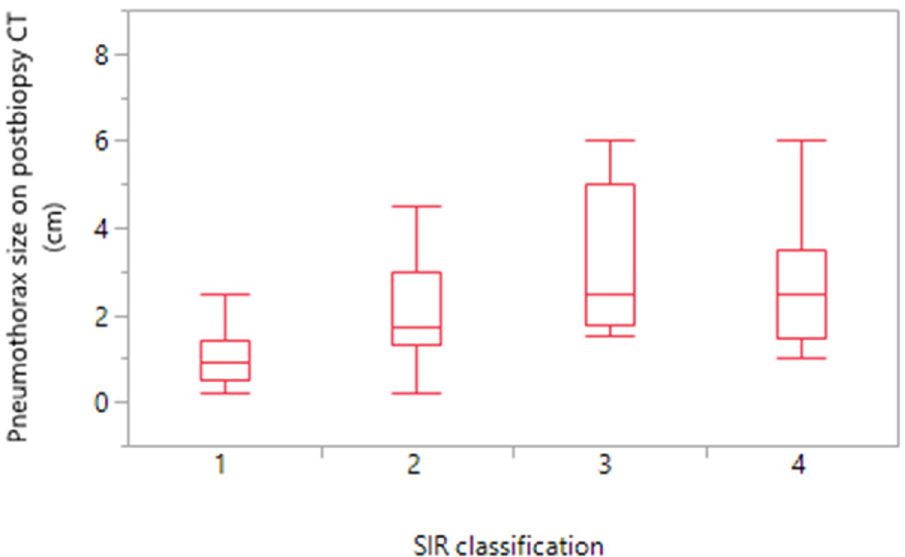
Fig 3. Pneumothorax size on post-biopsy CT images in relation to SIR classification. Box plots in the study group (n = 311).